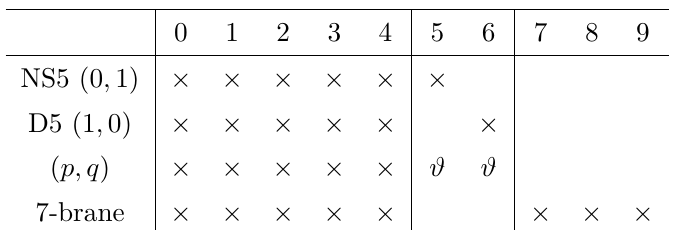
Table 1 . Type IIB 5-brane worldvolume configuration. The ( x 6 , x 5 ) -plane is referred to as the ( p, q ) -plane. The directions that each brane is extended are marked with × or ϑ .